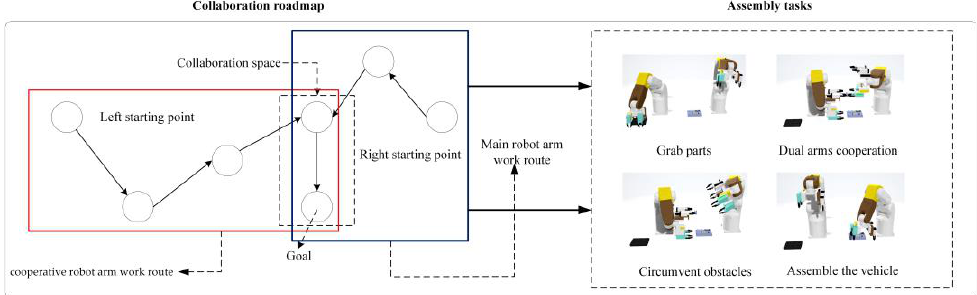
Figure 10. Key points in collaborative manufacturing of two-arm cooperation robot.